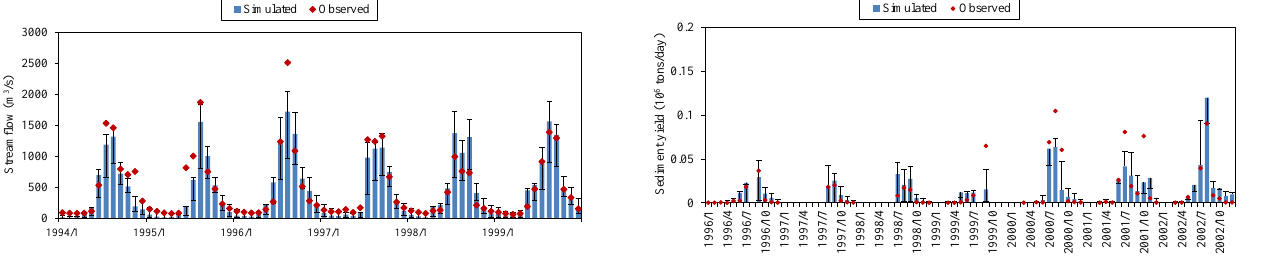
Fig. 11. Uncertainty analysis results of sediment yields for calibra- tion period. The 95PPU band is shown by thin black bars. (Note that the number of days used for calculating average sediment yield varies from 2 to 21 because of sporadic nature of sediment measure-